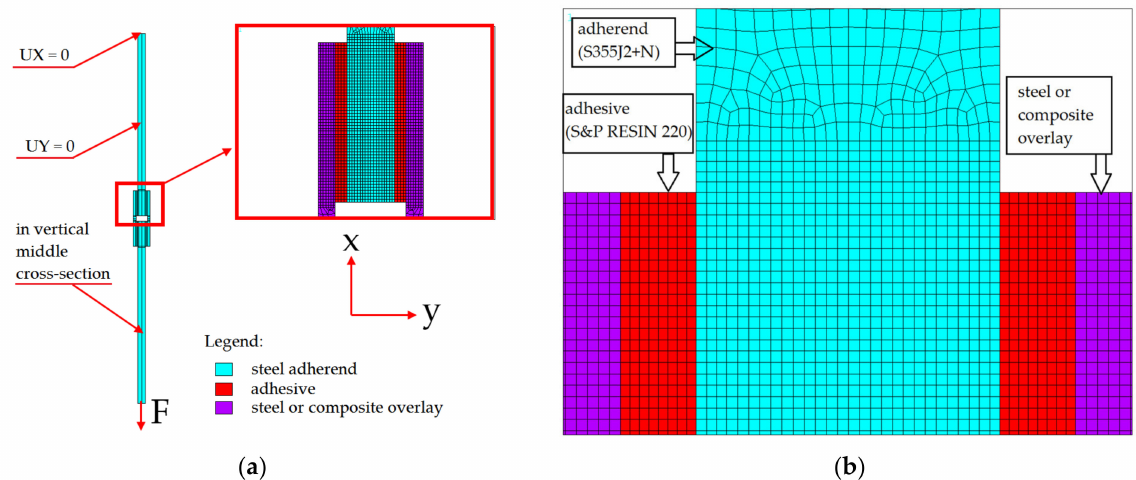
Figure 7. FEM model: ( a ) boundary conditions and part of FEM model with visible half-part of bonded joint and marked materials: light blue—steel adherend, red—adhesive, purple—overlays; ( b ) part of FEM model with finite element discretization.